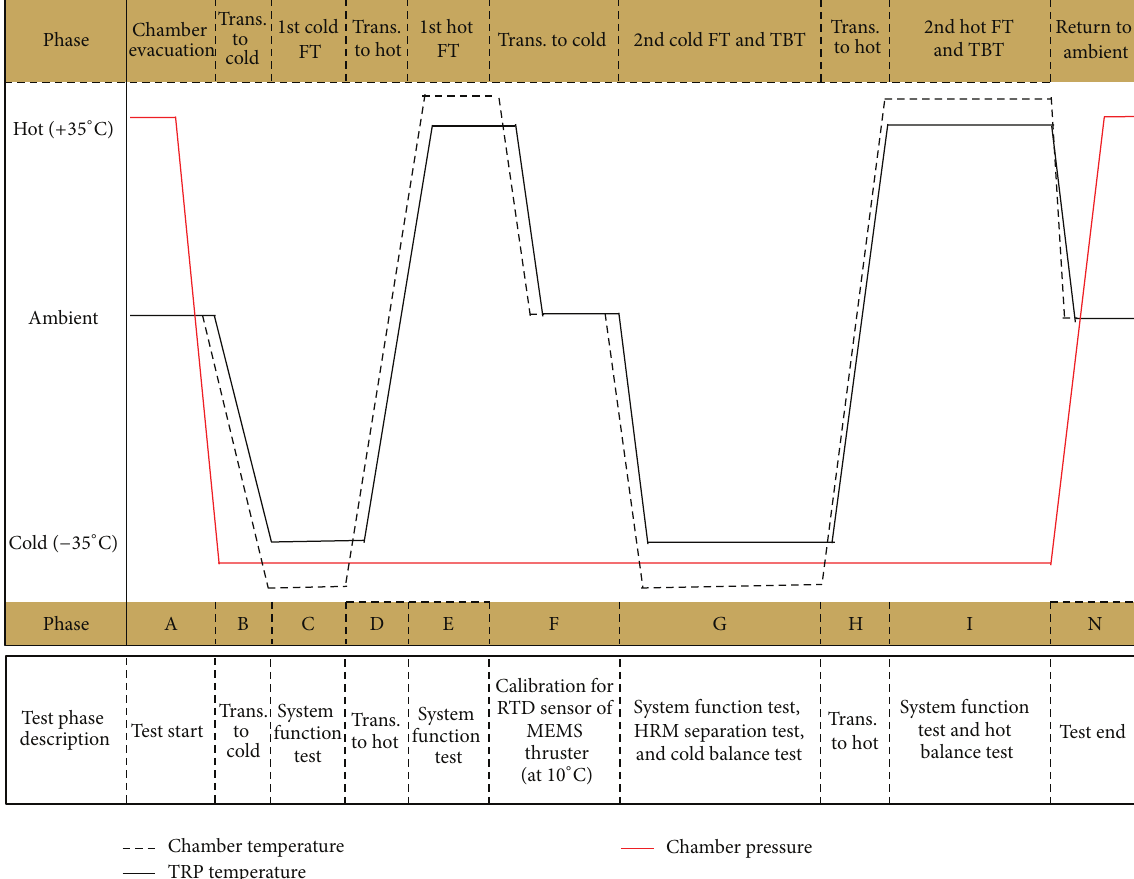
Figure 14: Thermal vacuum test profiles.